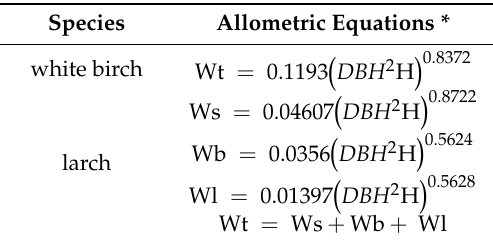
Figure 1. The shape and spatial distribution of field sampling plots within the coverage of lidar data. The background true color image was from GoogleEarth TM . ( a ) the shape and size of field sampling plots; ( b ) the spatial distribution of field sampling plots, the white polygon was the area covered by Unmanned Aerial Vehicle (UAV) stereo imagery. Table 1. Allometric equations used in this study.